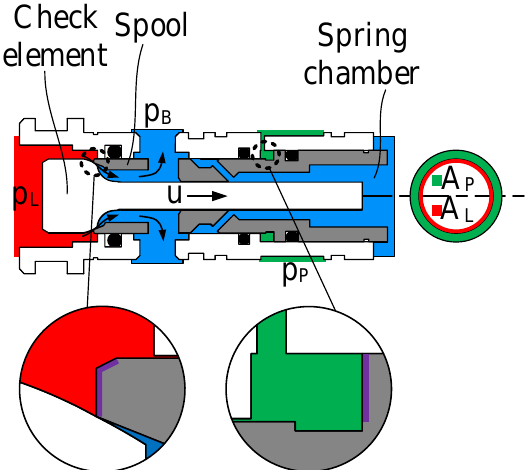
Figure 1: A section view of the CBV, with pressure indications, and effective cross-sectional ar- eas. Note scales on the two zooms are not the same. The surfaces marked with purple indicate the effective spool areas in the pro- jection.